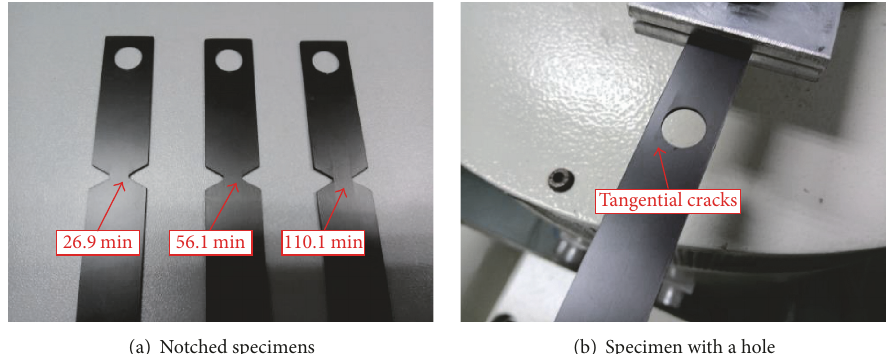
Figure 12: The vibration fatigue of